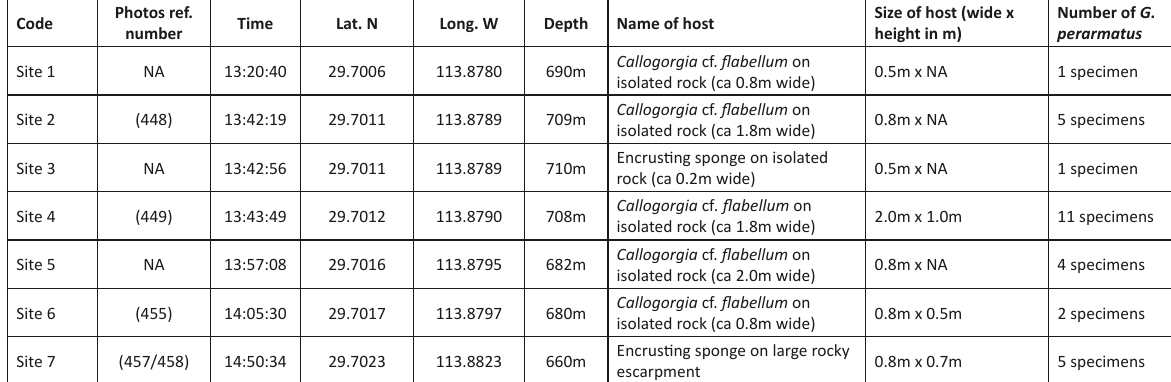
Table 1. Sites where Gastropthychus perarmatus was observed during the JASON J-337-2 dive (transect T4) in the Gulf of California, Mexico. Available environmental data and number of squat lobsters on each host are indicated. NA = not available. Photos ref. Code